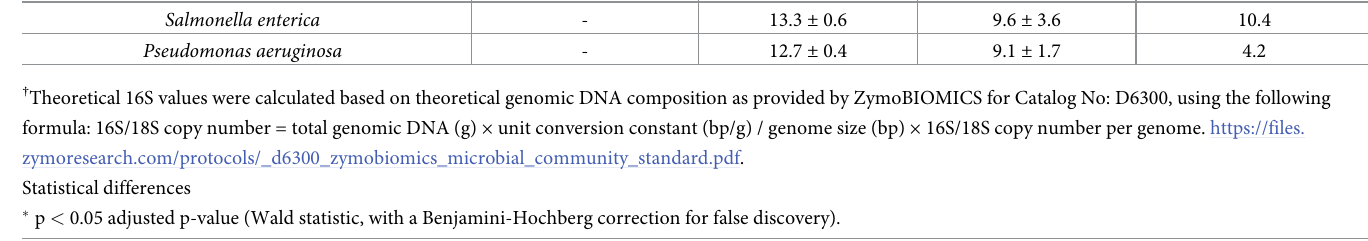
compared to the ZB kit. We speculate that the minimal steps and low bioburden reagents in the ZB kit contributed to lower 16S copies found in the negative extraction controls.